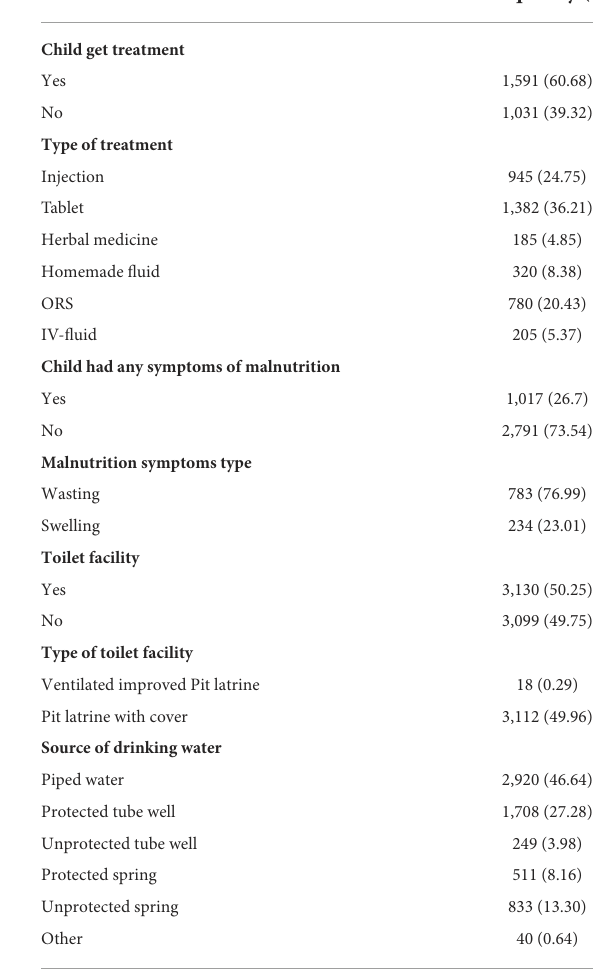
TABLE 1 Socio-demographic characteristics of under-five children in Kersa Health Demographic Surveillance System (HDSS) from 2016 to 2021.